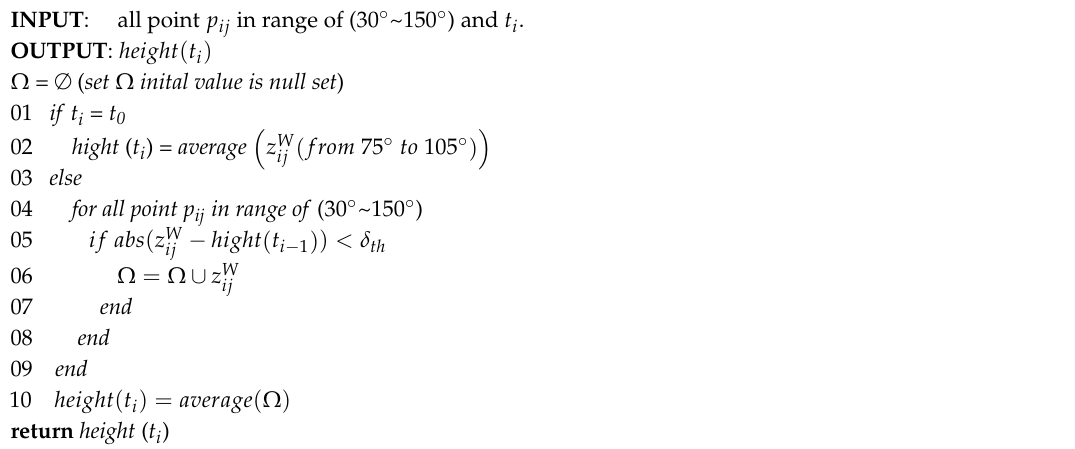
Algorithm 1: Height assessment of the scanned road